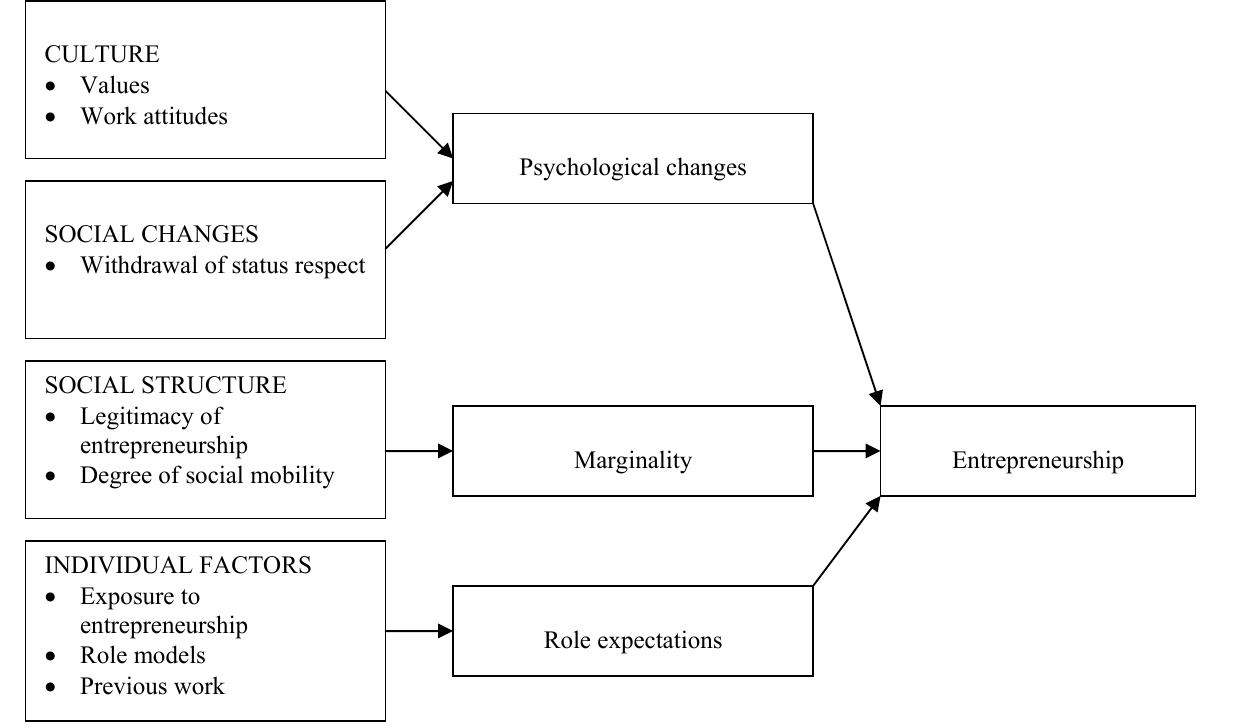
Figure 5: Conceptual model of socio-cultural approach to entrepreneurship